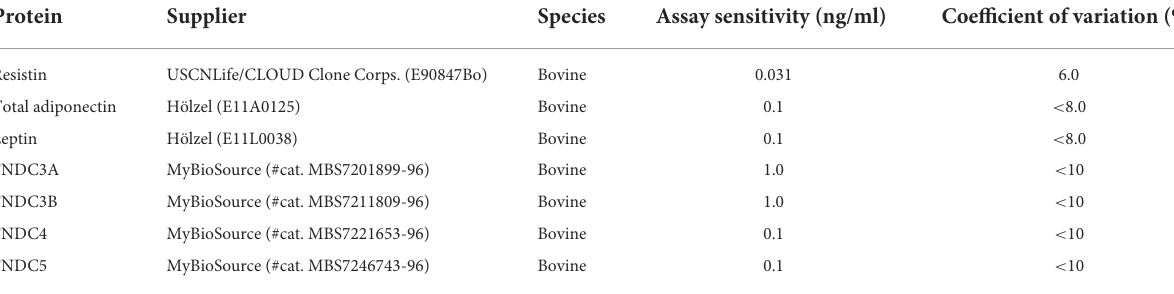
TABLE 2 List of ELISA assays used for measurement of bovine plasma FNDC concentration. Protein